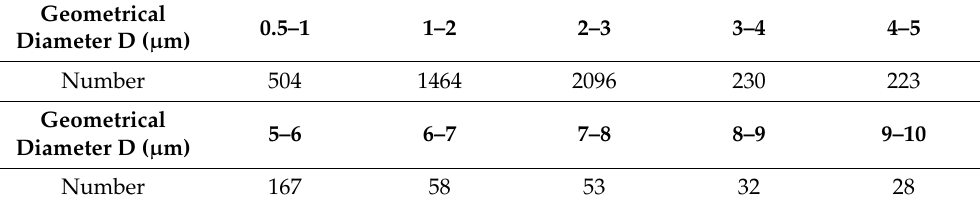
Table 1. Initial mineral distribution in char measured by